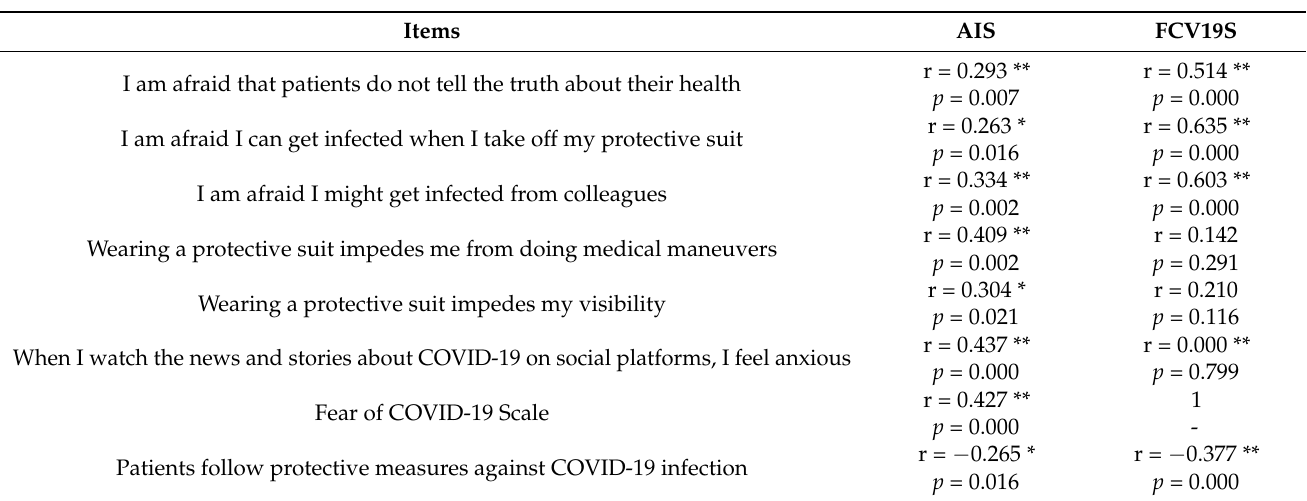
Table 4. Correlation analysis between Fear of Covid-19 Scale, Athens Insomnia Scale and self-rated items. Items AIS